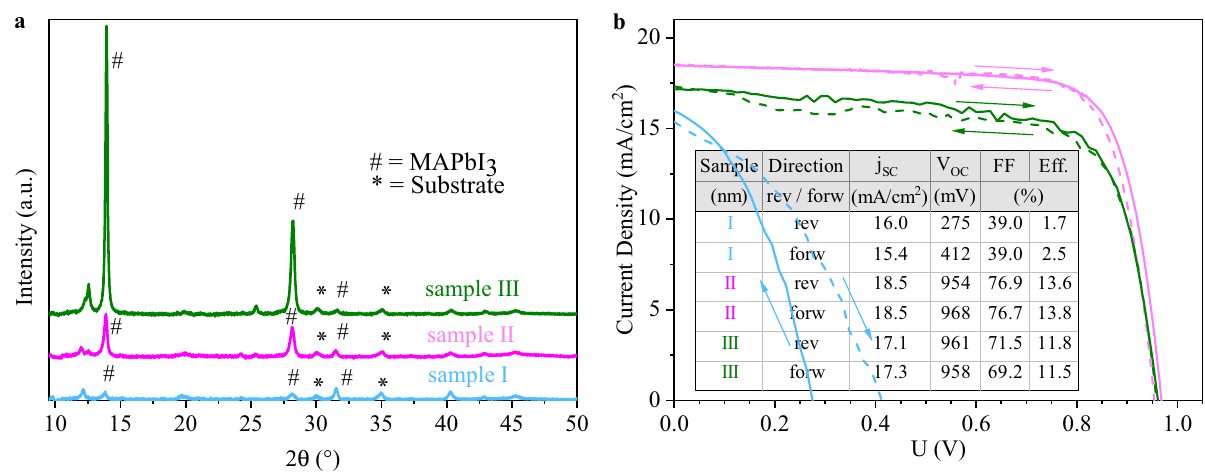
Figure 6. ( a ) θ –2 θ scans of samples I, II and III corresponding to MAI evaporation onset times of t = 0/8/16 min. ( b ) Current–voltage characteristics for the best MAPbI 3 cells prepared from samples I, II and